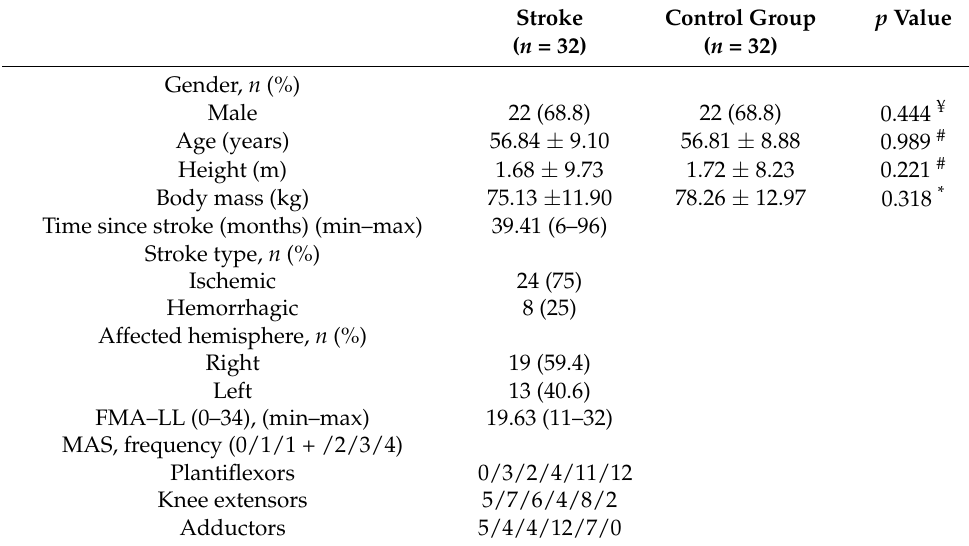
Table 1. Participant characteristics.